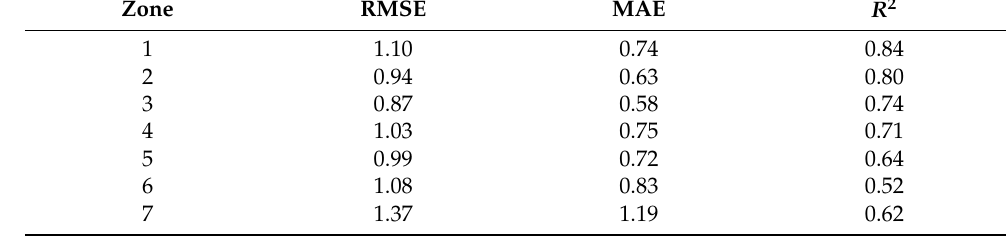
Table 4. Statistical indicators of reference evapotranspiration in different climate zones of China. Zone